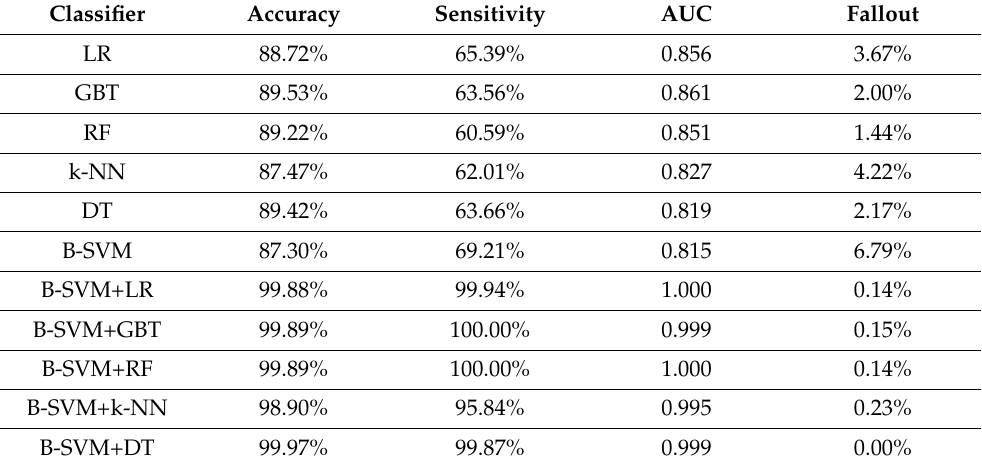
Table 5. Predictive performance of classification algorithms without and with SVM pre-processing for the DMEF3